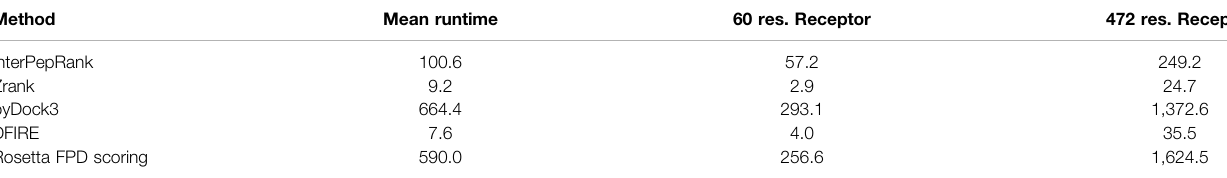
TABLE2| Averageruntimefor70,000decoysoveralltargets,asmeasuredinminutes.AllcalculationswereperformedonasingleCPUcoreofIntelXeonGold6130running on CentOS 7, and when applicable an Nvidia GeForceRTX 2080Ti graphics card wasavailable. IfInterPepRankisrun completely on CPU, add approximately30 min to the mean runtime. The average receptor size of the set is 156 residues.